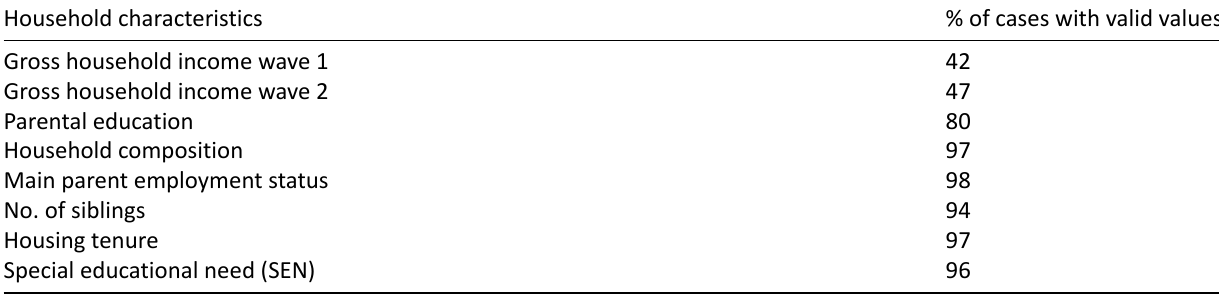
Table 1. Completeness of records in wave 1 of Next